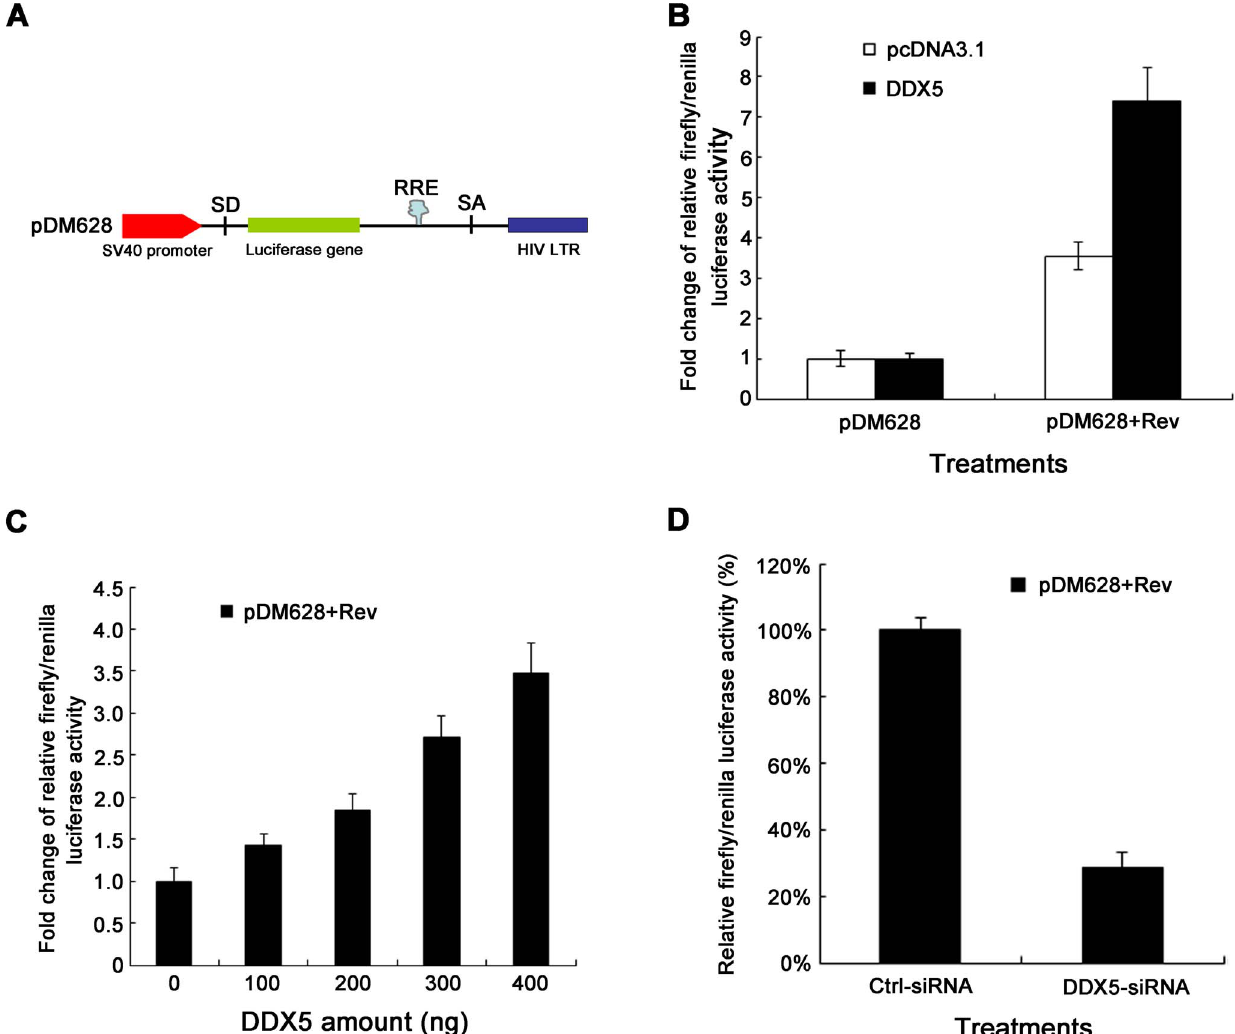
Figure 2. DDX5 significantly enhances the expression of a Rev-dependent reporter gene. A . Schematic diagram of construction of pDM628. B and C . The 293T cells were co-transfected with pDM628, pRL-TK (as a transfection normalization reporter), pcDNA3.1-Rev and pcDNA3.1- DDX5-HA (or pcDNA3.1). The cells were lysed at 48 h p.t. for luciferase activity assay. D . pDM628, pRL-TK, pcDNA3.1-Rev and DDX5-siRNA were transfected into 293T cells. After 48 h, cells were lysed for luciferase activity assay. Data in B , C and D represent mean 6 S.D. (error bars).